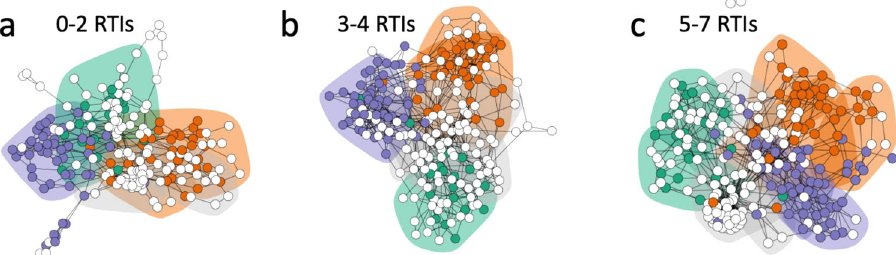
Fig. 3 Cross-niche networks for each RTI group at week 1. Microbial cross-niche networks using data from the nasopharynx, gut, and oral cavity ( a – c ). Nodes represent individual OTUs and were coloured depending on their indicator species identity (orange = faeces-speci fi c, green = nasopharynx-speci fi c, blue = saliva speci fi c, white = not niche-speci fi c). Shaded areas around groups of nodes represent clusters de fi ned by walktrap community analysis and are shaded depending on their niche identity (orange = faeces-speci fi c, green = nasopharynx-speci fi c, blue = saliva speci fi c, grey = mixed cluster/not niche- speci fi